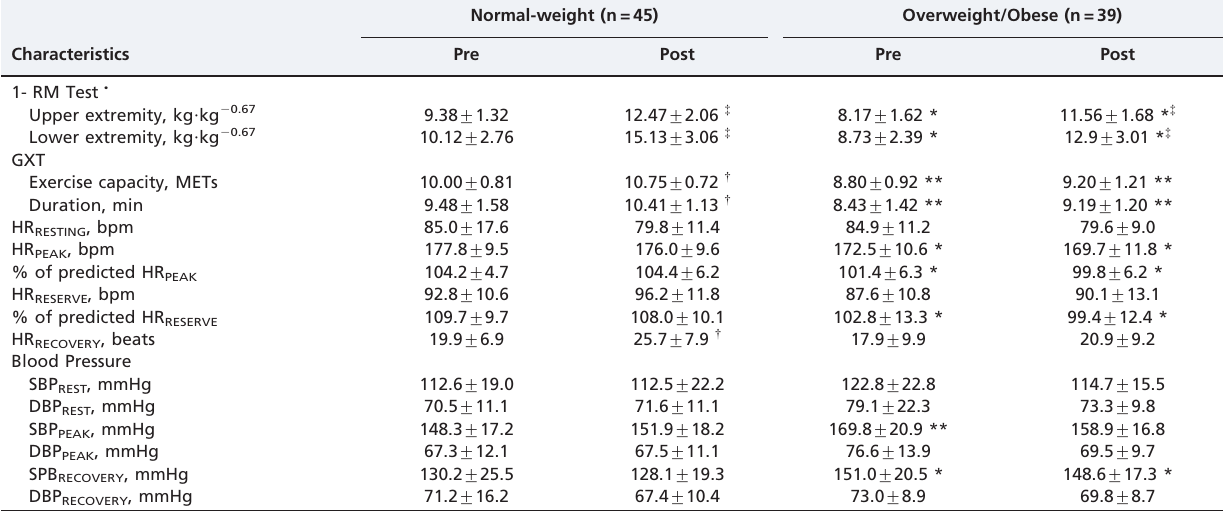
Table 4 - Muscle strength, cardiorespiratory fitness, heart rate and blood pressure responses to exercise before and after 12 months of exercise